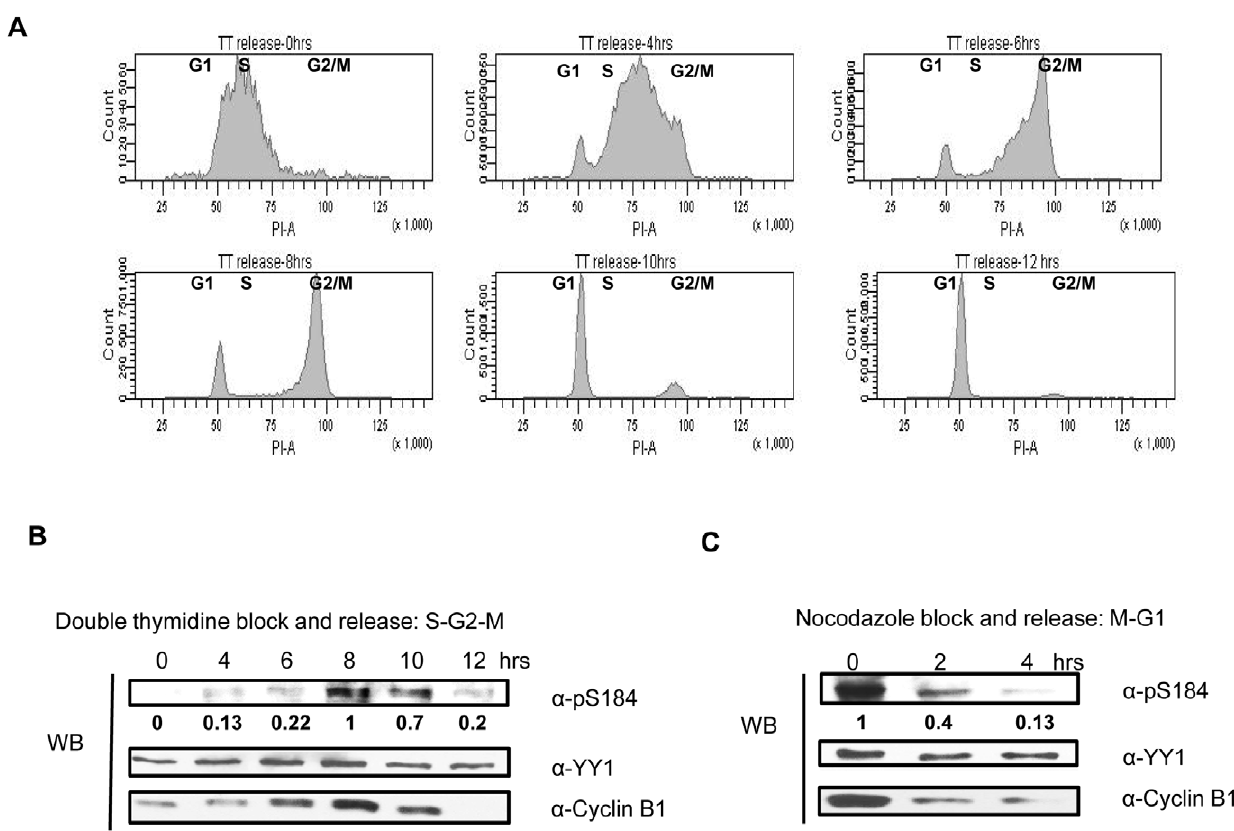
Figure 2. Serine 184 phosphorylation on YY1 peaks at the G2/M stage of the cell cycle. ( A ) Cell cycle progression of HEK293 cells released after double-thymidine (2.5 mM) block was analyzed by fluorescence-activated cell sorting. Cells were stained with propidium iodide to analyze DNA content. ( B ) HEK293 cells were synchronized at early S phase by double-thymidine block and then released into fresh media. Western blot was performed on HEK293 cell lysates collected at the indicated time points. The blot was probed with anti-pS184 antibody with relative levels indicated below, then anti-YY1 antibody, followed by anti-cyclin B1 antibody. ( C ) HEK293 cells were also synchronized in mitosis by nocodazole block (100 ng/ ml) for 18 hours and then released into fresh media. Western blot was performed on HEK293 cell lysates collected at the indicated time points after nocodazole block and release. The blot was probed with anti-pS184 antibody with relative levels indicated below, then anti-YY1 antibody followed by anti-cyclin